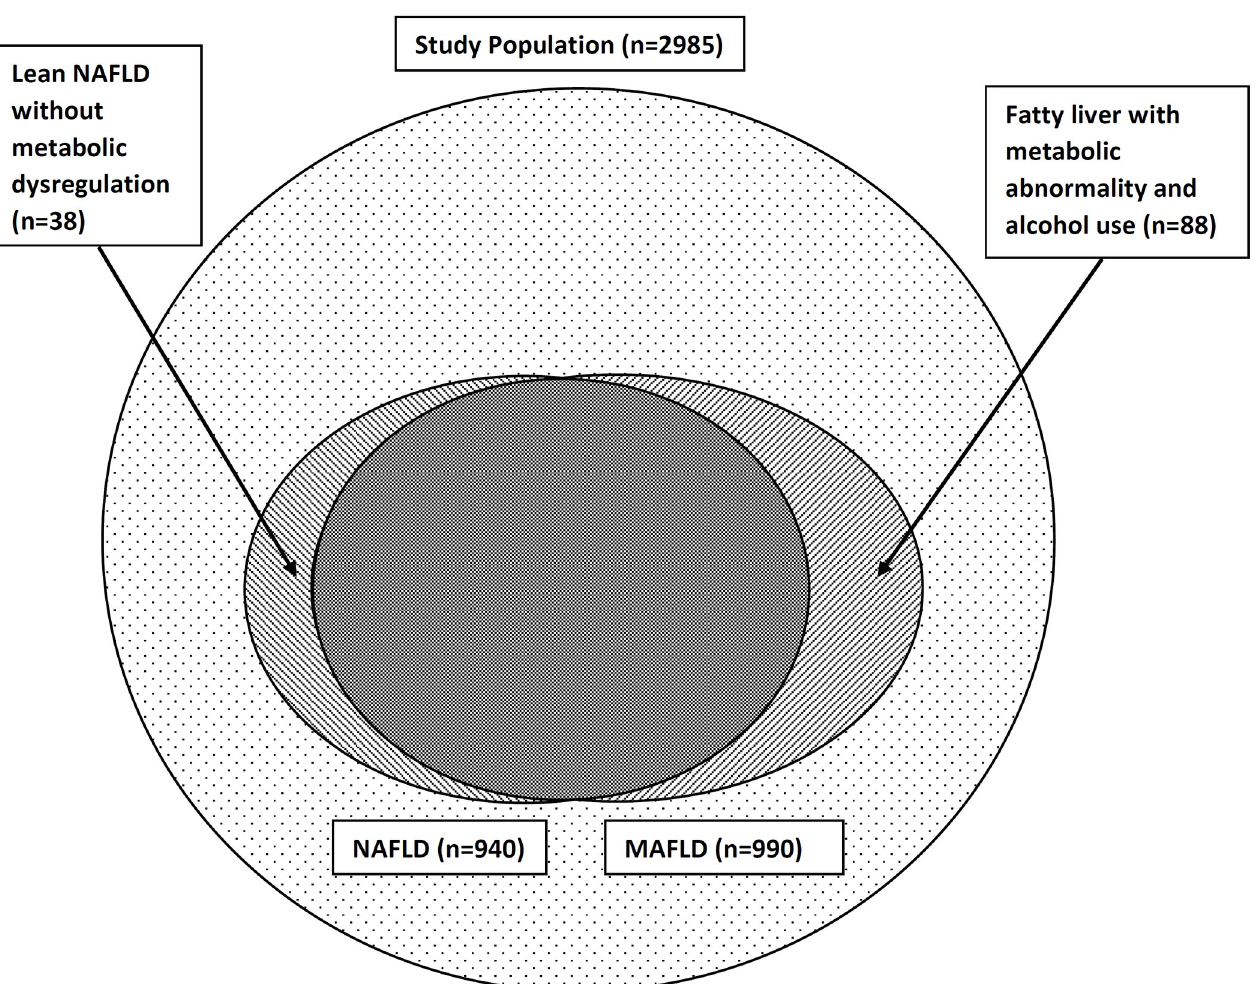
Fig 1. MAFLD, NAFLD and those excluded by the two definitions in the original study population.